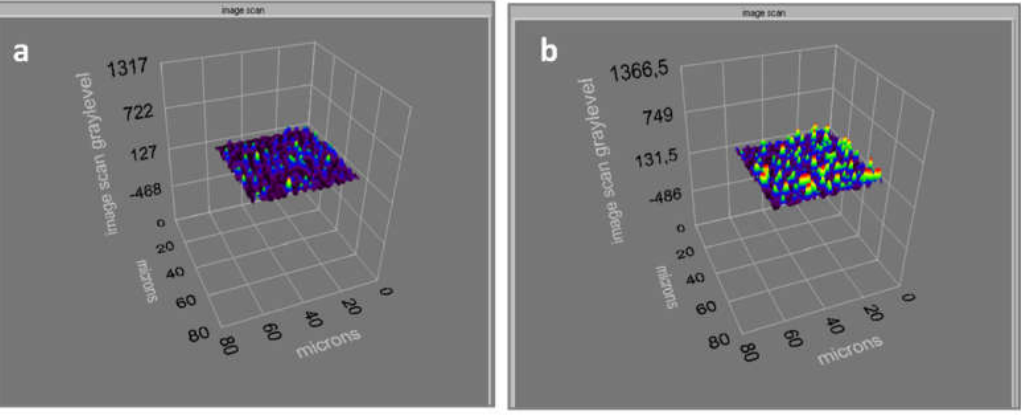
Figure 3. The ellipsometer images of Cu(II)-MIP1 ( a ) and Cu(II)-MIP2 ( b ) nanoparticles.